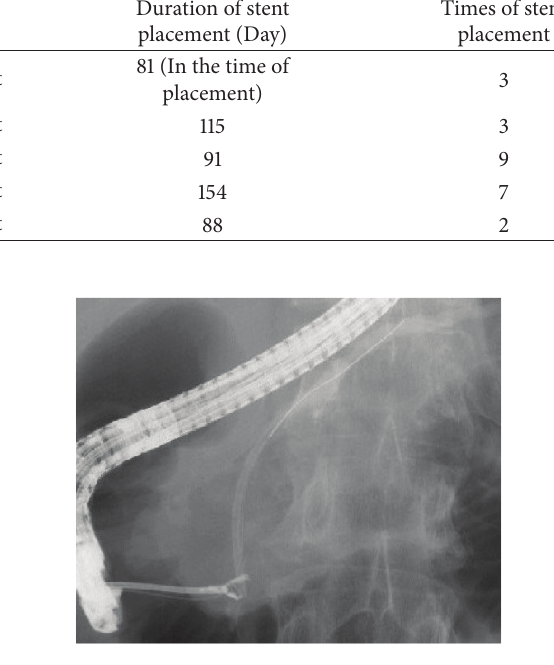
Figure 1: This retrieval technique is a method that directly grasps the distal end of the migrated stent using a rat-toothed